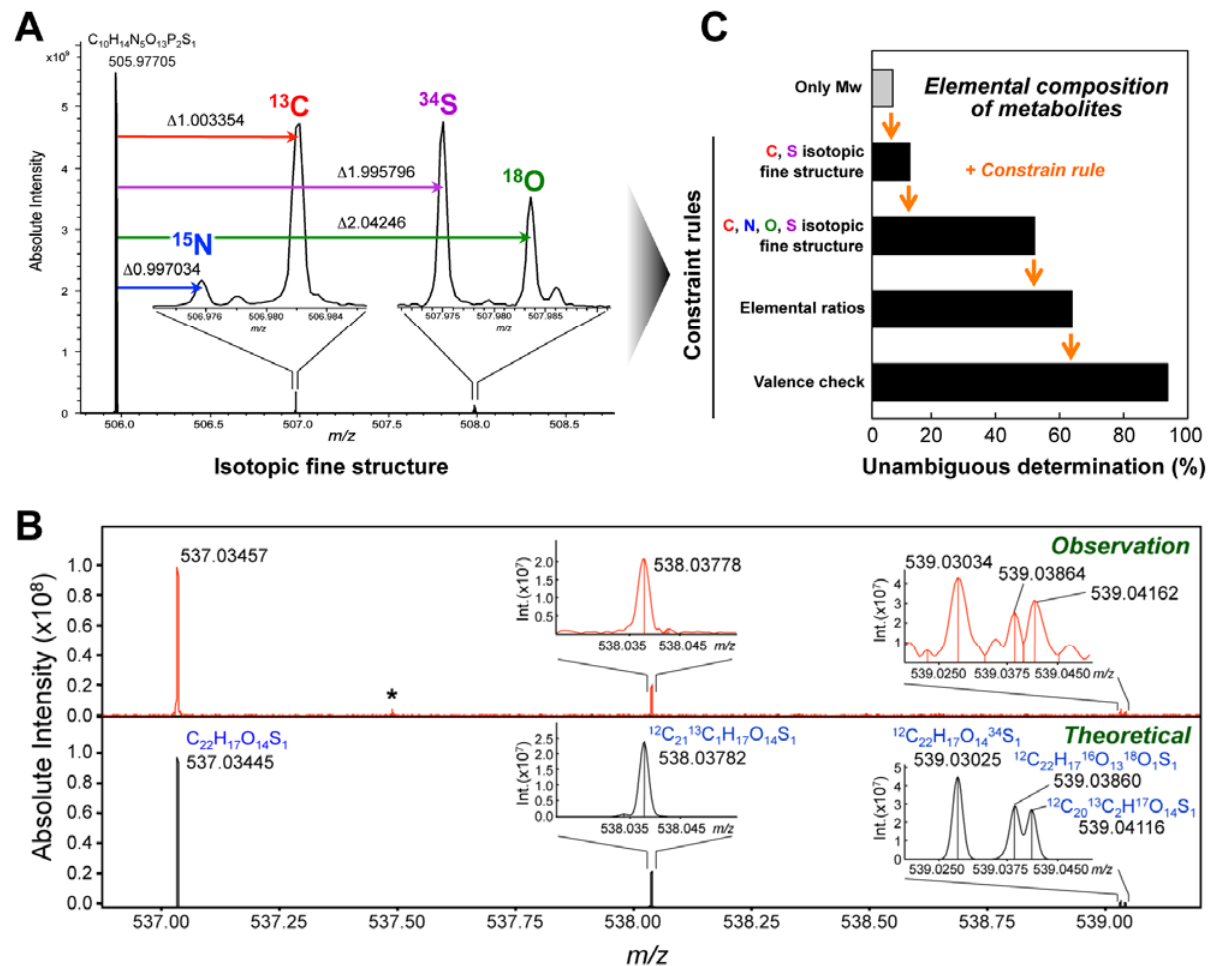
H O N P S ) by 10 15 13 5 2 1